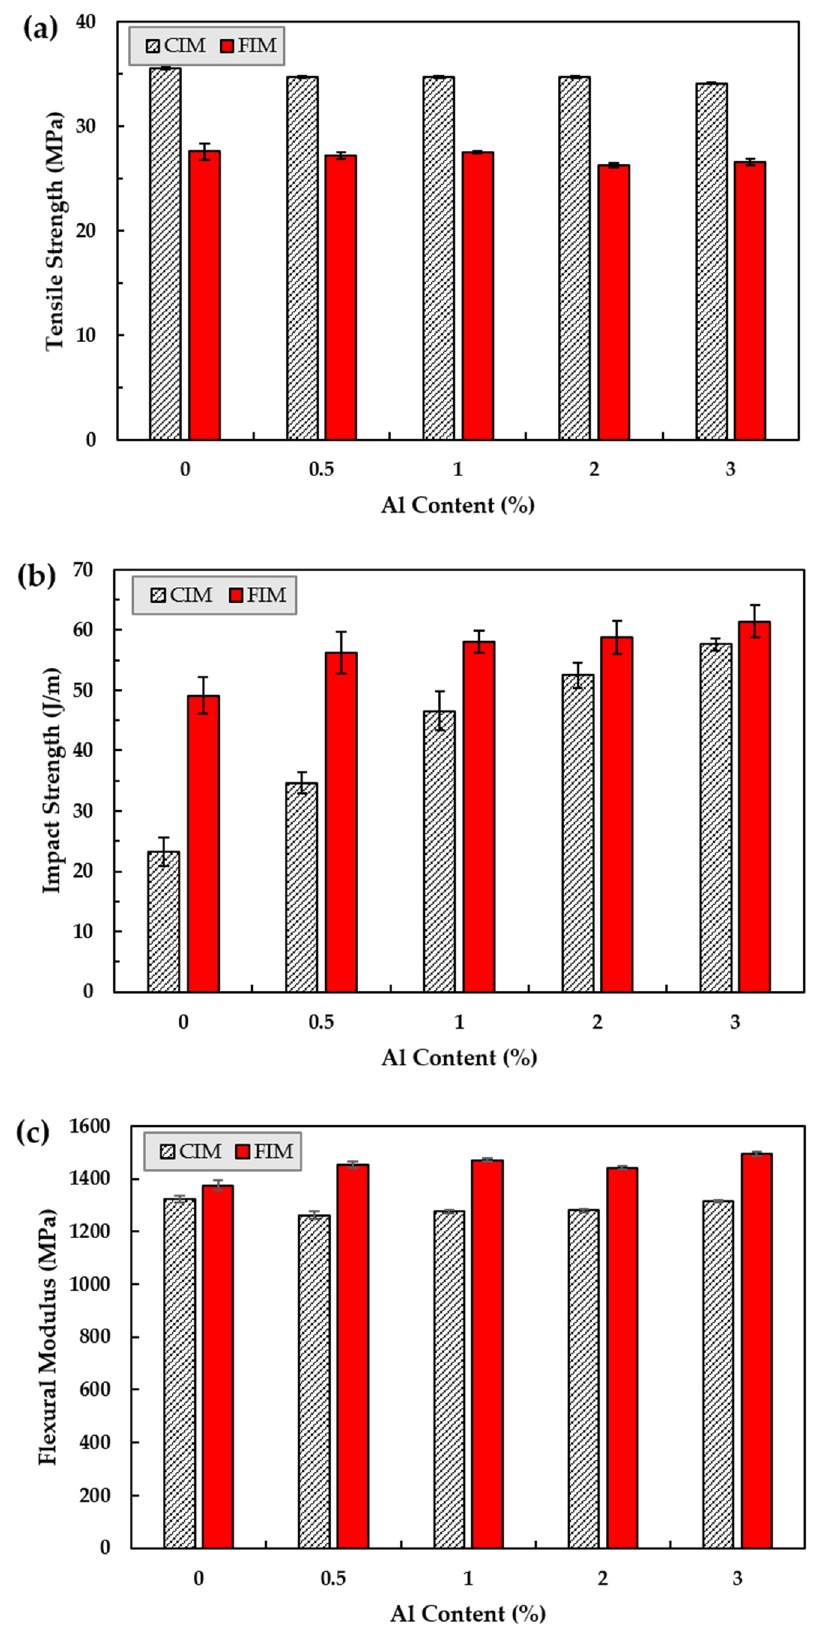
Figure 8. Summary of mechanical properties with different quantities of aluminum flake, ranging from 0 to 3 wt%; ( a ) Tensile strength; ( b ) Impact strength; ( c ) Flexural modulus.